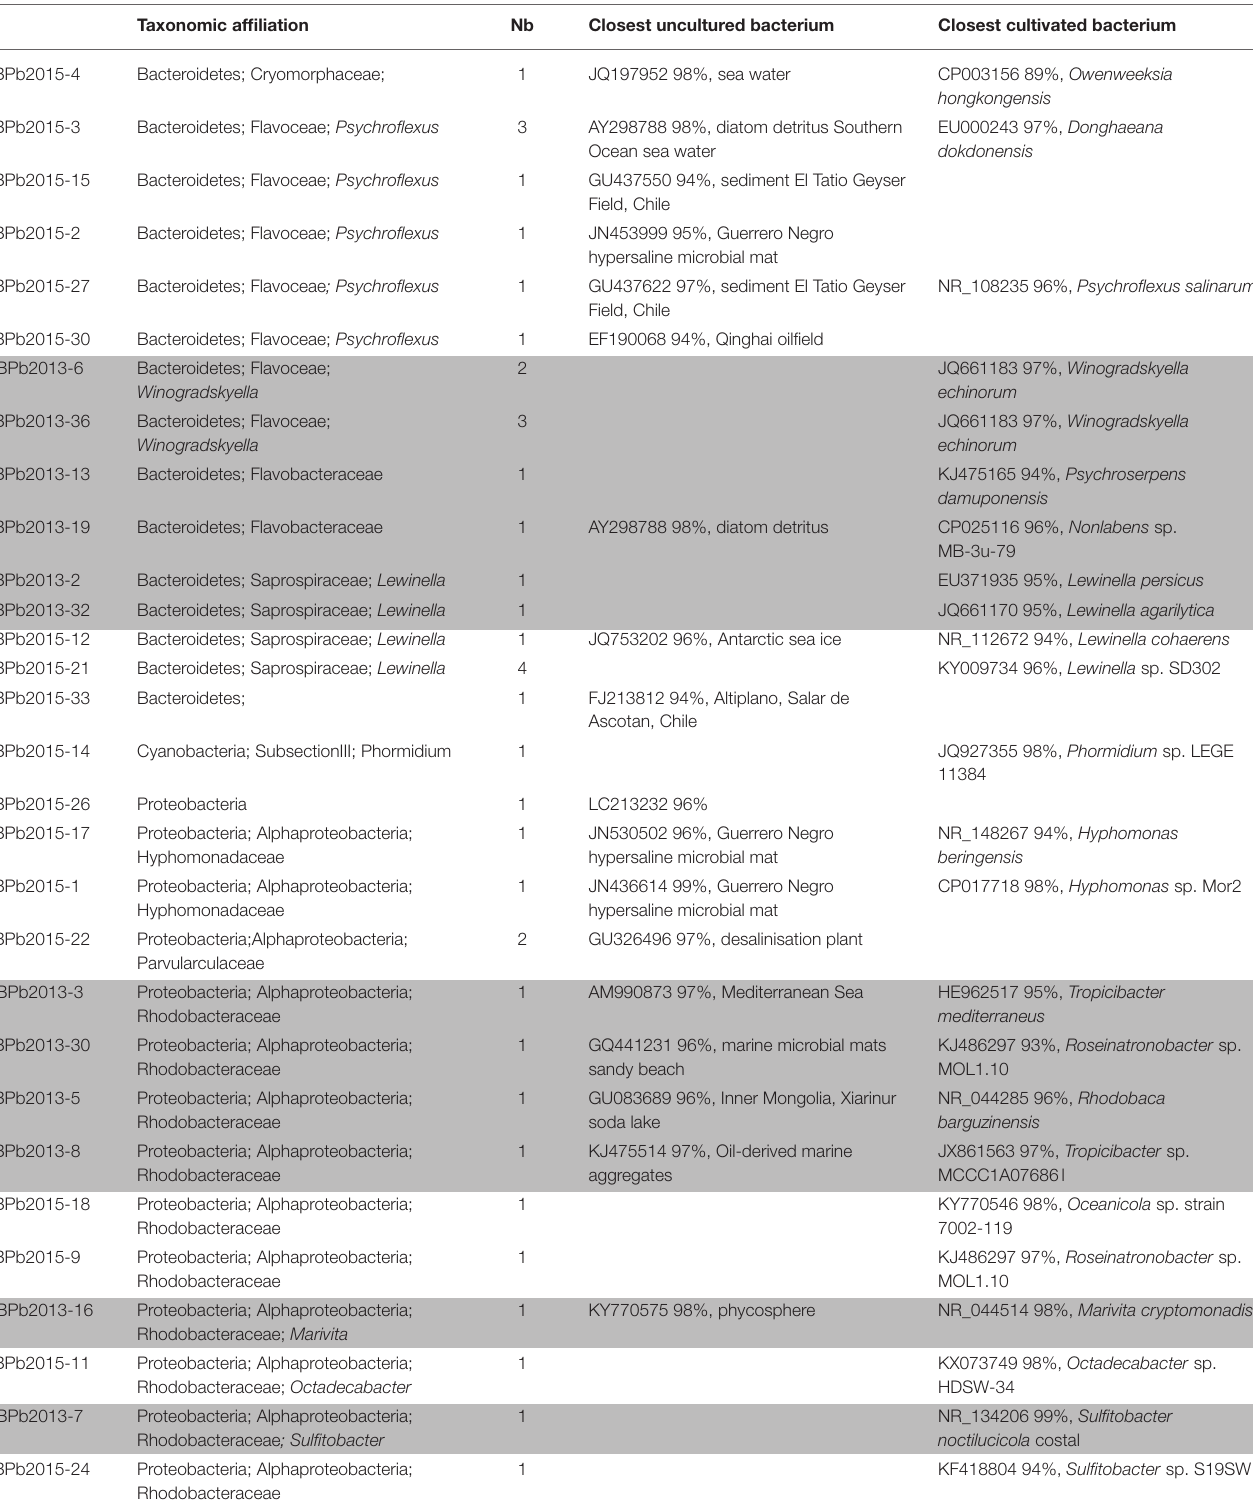
TABLE 2 | Taxonomic affiliations of the bacterial 16S rRNA gene sequences using general bacterial primers retrieved from the BP mats collected in 2013 (gray) and 2015 (white). Taxonomic affiliation Nb Closest uncultured